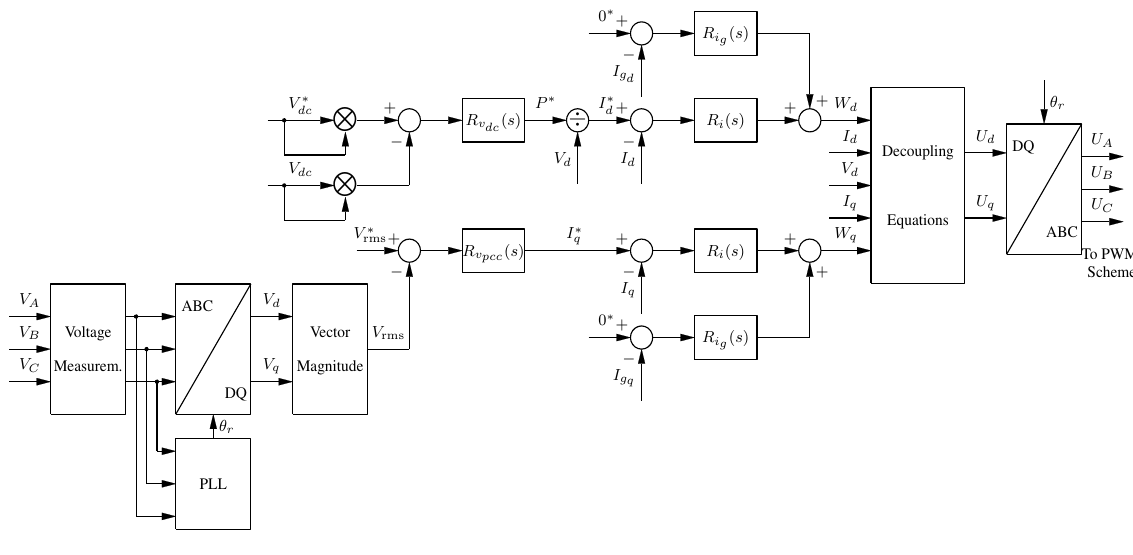
Figure 4. Block diagram of the control system of the DSTATCOM. PLL, phase locked loop. Figure 4. Control system for the